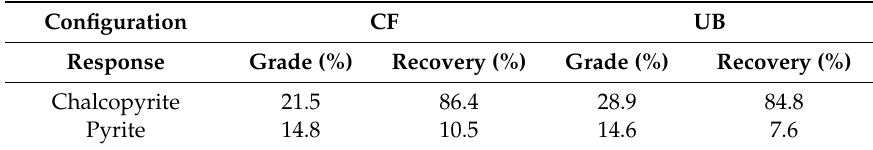
Table 5. Final grades and recoveries of chalcopyrite and pyrite obtained in non-treated and ultrasonic-treated flotation